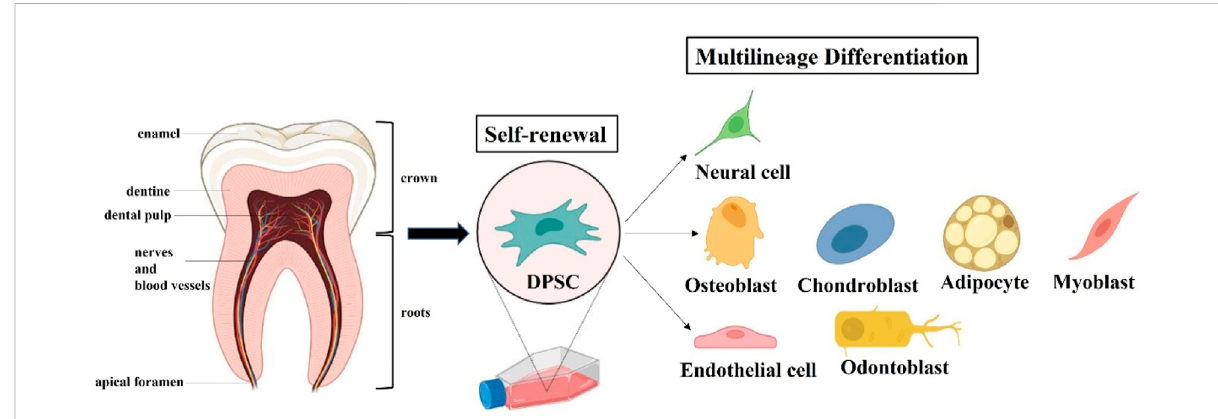
FIGURE 3 Extraction and Characteristics of dental pulp stem cells (DPSCs). DPSCs can be extracted from the tooth pulp tissue of adult molars and hold self-renewal and multilineage differentiation